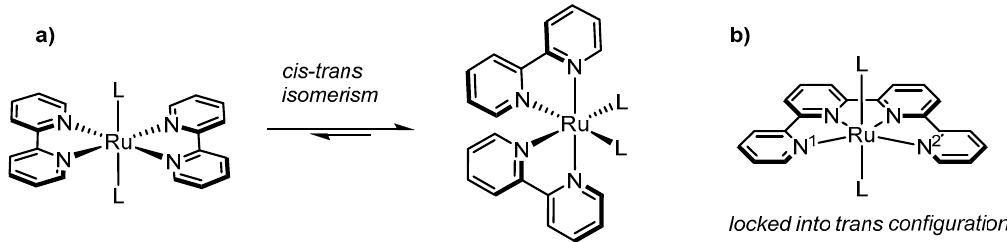
Figure 10. ( a ) Depiction of a common scenario of cis - trans isomerism in Ru(bpy) 2 (L) 2 complexes where the cis configuration is favored, ( b ) utilization of a tetradentate ligand as a strategy to prevent isomerization.